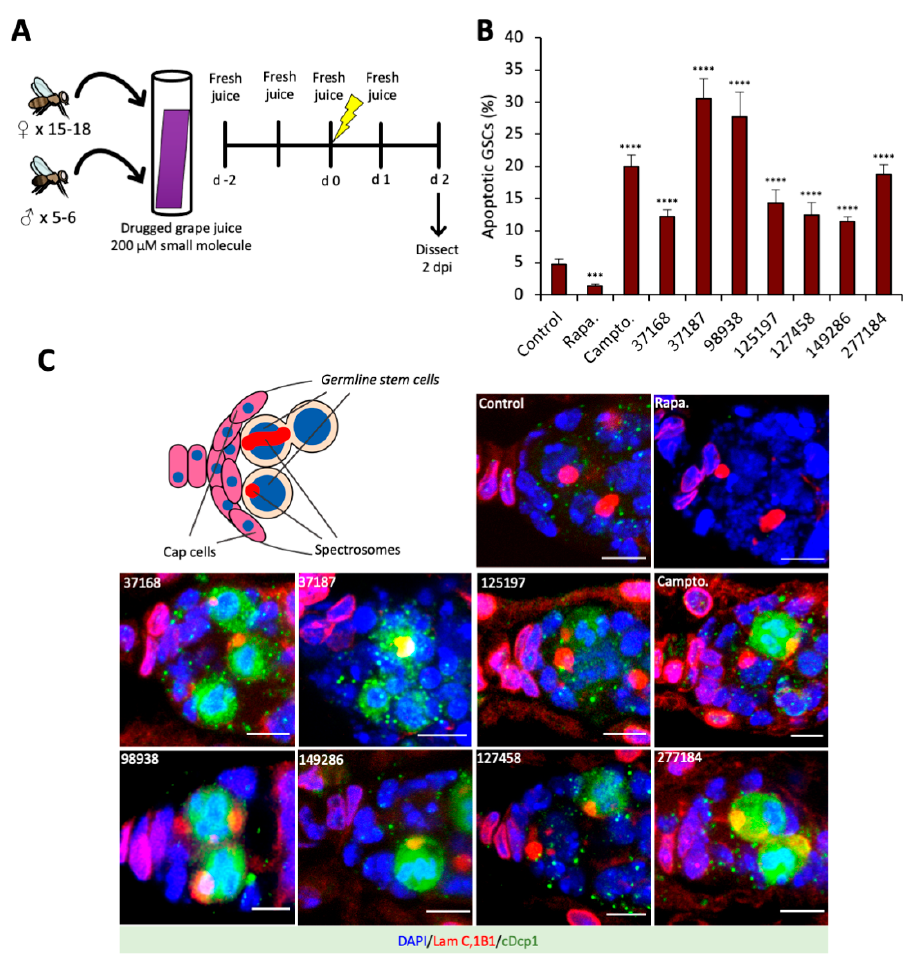
Figure 2. Secondary screen for GSC apoptosis in irradiated female fruit flies fed drug-spiked grape juice ( A ) Diagram of experimental set up for small molecule screen of pro-apoptotic drugs in grape juice in female GSCs. New grape juice containing 200 µM of respective drugs is given to flies every day during the irradiation treatment. Flies are dissected for ovaries at 2 dpi. ( B ) Percentage of apoptotic GSCs, computed as a ratio of cDcp+ positive GSCs to all GSCs. ( C ) Cartoon model of the GSC niche depicting spectrosome-containing GSCs in contact with somatic cap cells, and representative images of germaria with apoptotic female GSCs after specified drug treatment and post-irradiation (2 dpi). Stained with 1B1 (spectrosomes/fusomes, red), LamC (Cpc and TF, red), cDcp1 (apoptosis, green) and DAPI (nuclei, blue). (Scale bar 5 µm). Significance is calculated by Chi-squared test between control (DMSO) and each drug treated condition, *** p ≤ 0.001, **** p ≤ 0.0001.